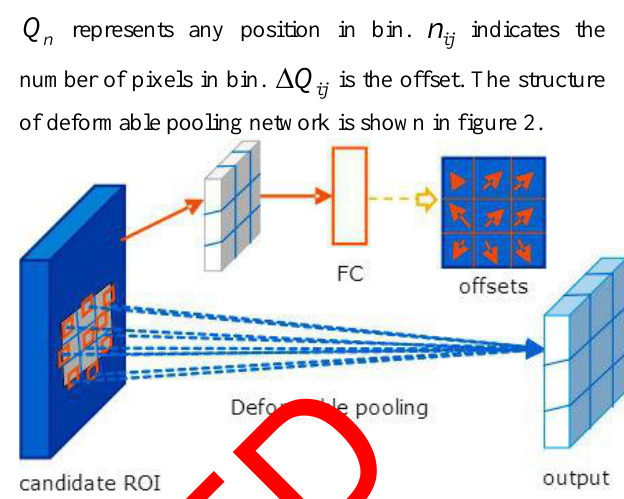
Candidate regions of interest (ROI) are obtained by pooling the feature map [19,20]. Then the offset of the region of interest is obtained through the new full connection layer (FC). The input and output of the deformable convolutional network are the same as that of the ordinary convolutional network, except that during training, the newly added weights of the convolutional layer and the full connection layer for learning the offset are initialized to zero. The deformable part is actually a model composed of a root filter and a component filter. The quality of DPM model is mainly determined by component